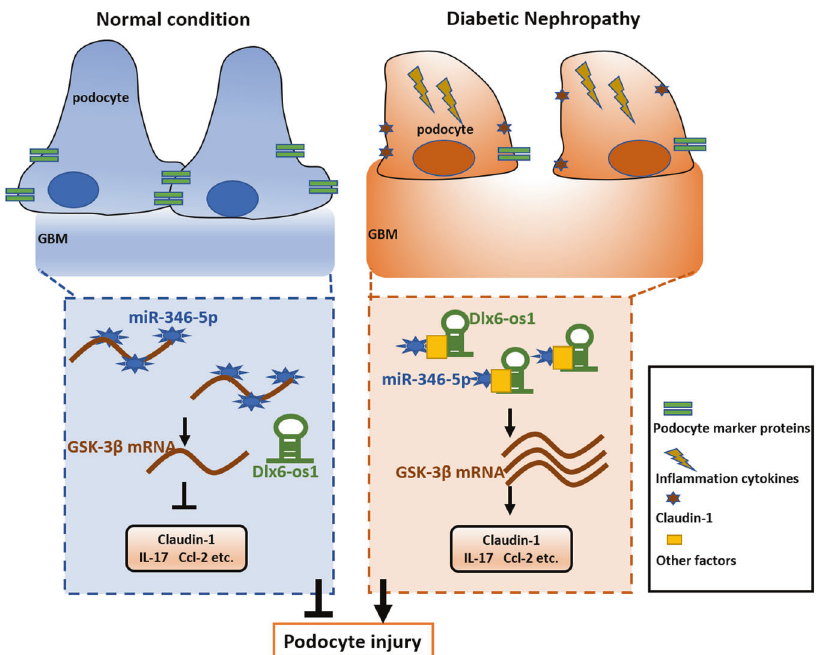
Fig. 10 Proposed mechanism by which lncRNA Dlx6-os1 induces podocyte injury leading to diabetic neuropathy (DN). Left panel: Under normal circumstances, lncRNA Dlx6-os1 expression in renal podocytes is at a basal level, with no change or a slight reduction in diabetic individuals. Podocyte marker protein expression is normal, and in fl ammatory and injury-associated factors are rarely expressed. Right panel: In individuals with diabetic nephropathy, lncRNA Dlx6-os1 expression is increased, resulting in GSK-3 β upregulation, thus leading to increased expression of in fl ammatory factors and cell damage-associated factors, podocyte injury and